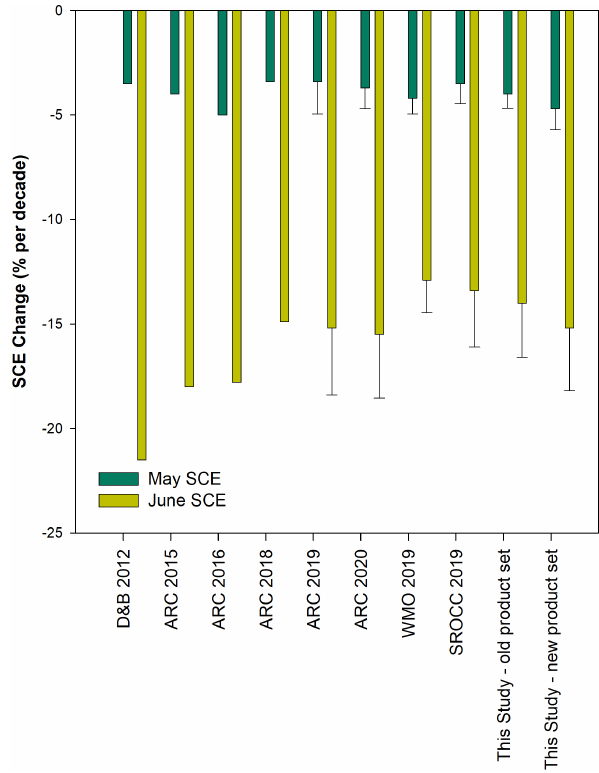
Figure 9. May and June Arctic snow cover extent rates of change from various assessments over the past